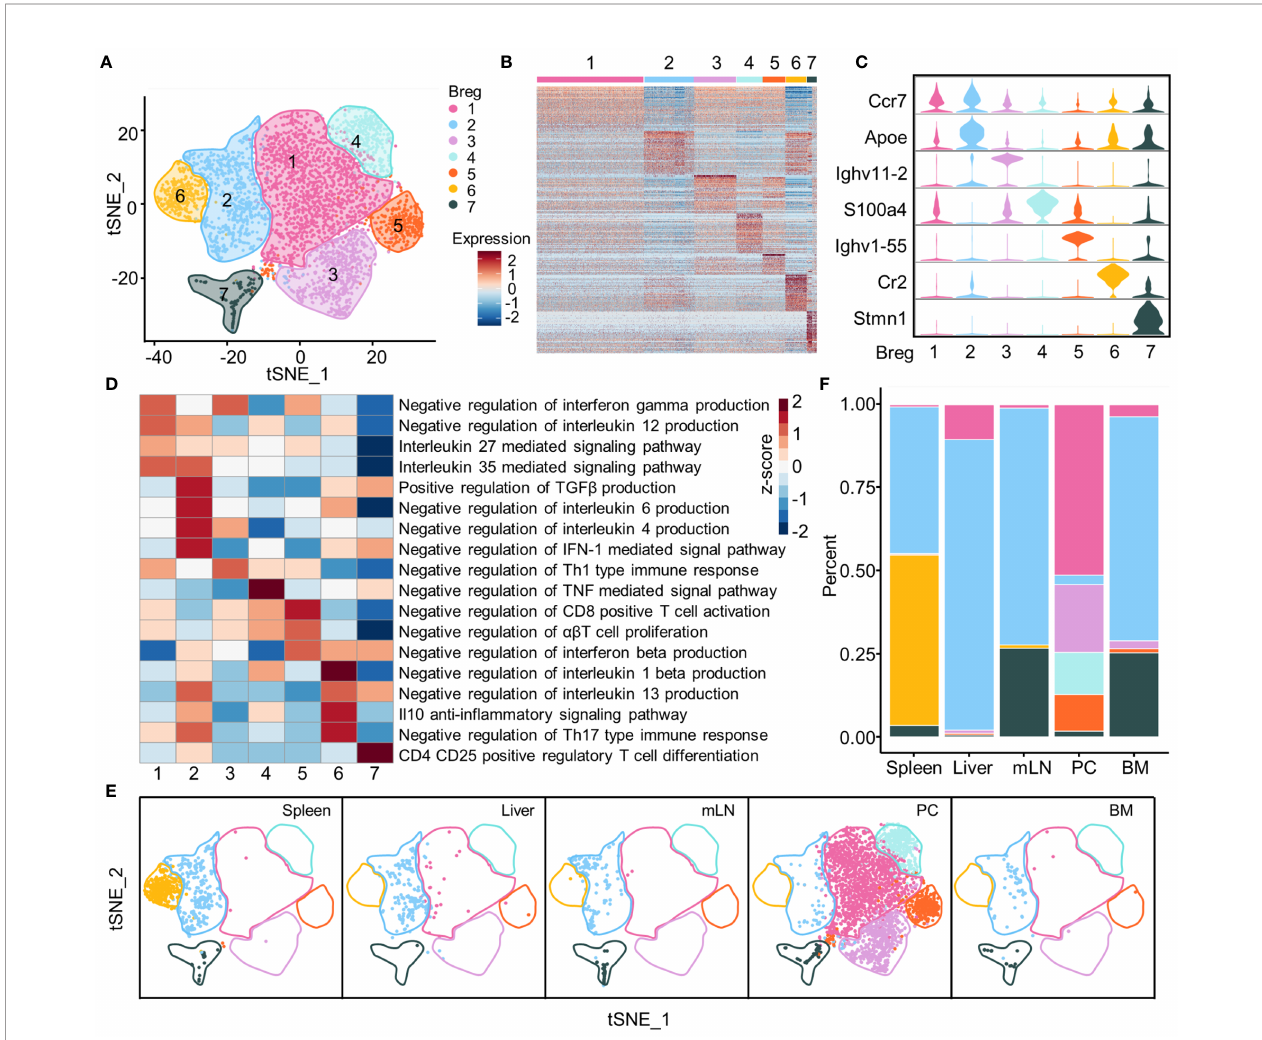
FIGURE 3 | Subsets of Breg cells. (A) t-SNE plot of identi fi ed Breg cells from all organs showing seven clusters. (B) Heat map of top 50 genes in each subset of Breg cells from all organs. (C) Violin plots showed the normalized expression of the marker genes in each Breg cell subset from all organs. (D) GSVA analysis of immunoregulation pathways in Breg cell clusters from all organs. (E) Distribution of Breg cell subsets in spleen, liver, mLN, PC, and BM. (F) The proportion of Breg cell subsets in spleen, liver, mLN, PC, and